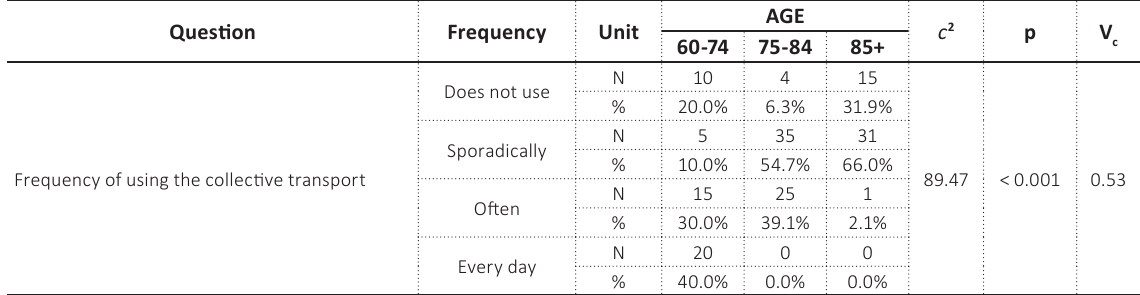
Table 2. Cross-table presenting the number and percentage of answers to the question “How often do you use collective transport?” depending on age